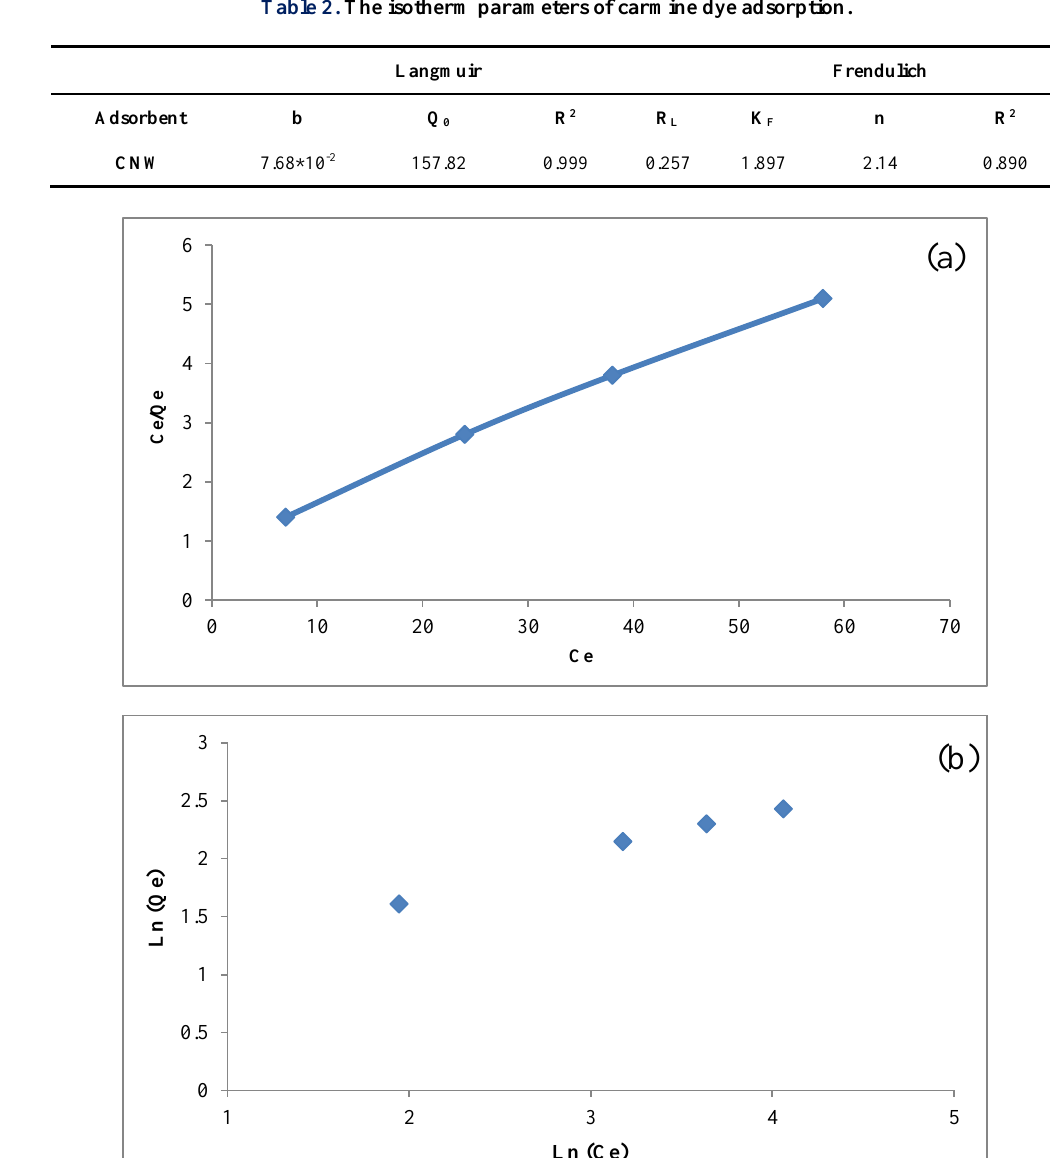
Table 2. The isotherm parameters of carmine dye adsorption. Langmuir Frendulich